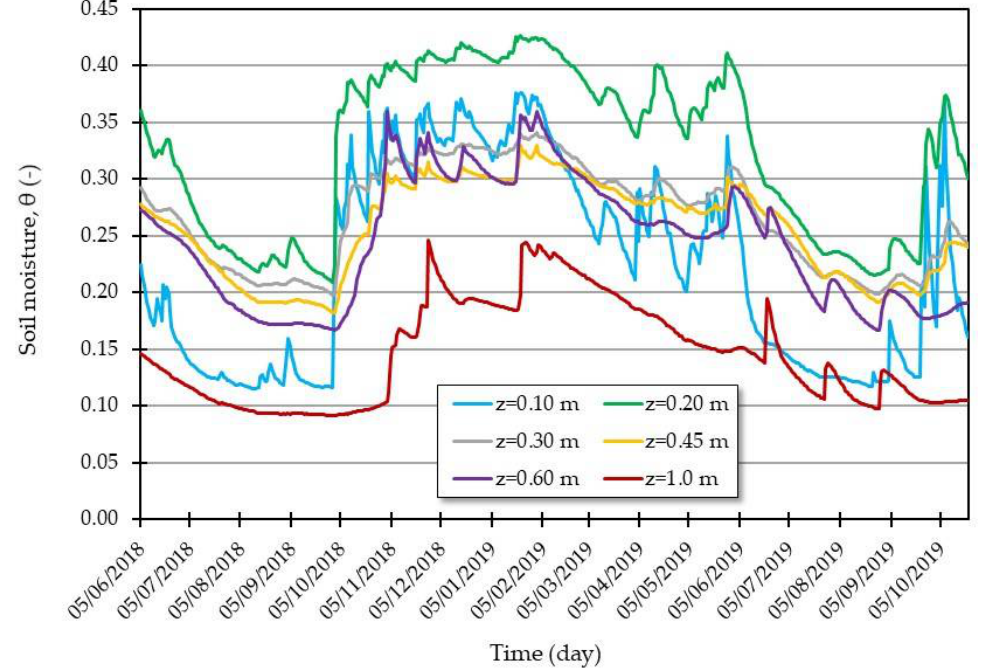
Figure 6. Time variations of soil moisture at the San Giuseppiello site as measured by the GS3 capacitance probes positioned at different soil depths.